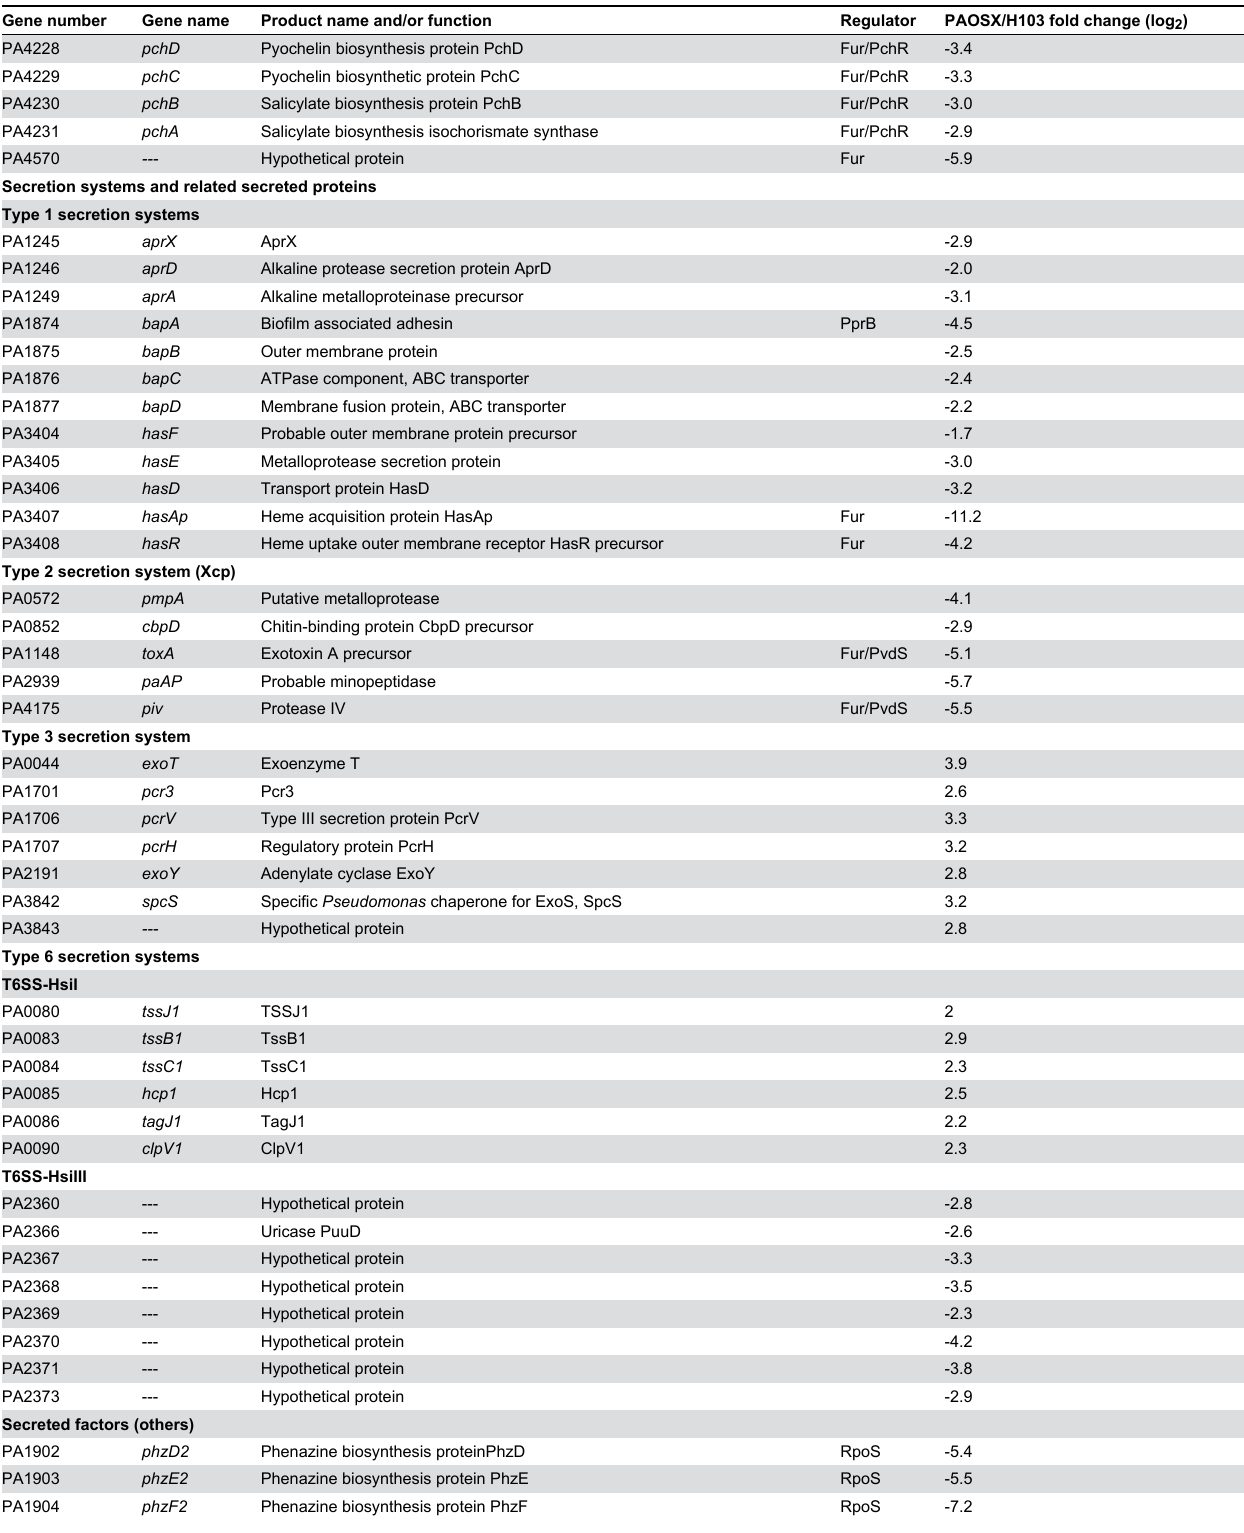
PA1903 phzE2 Phenazine biosynthesis protein PhzE RpoS -5.5 PA1904 phzF2 Phenazine biosynthesis protein PhzF RpoS